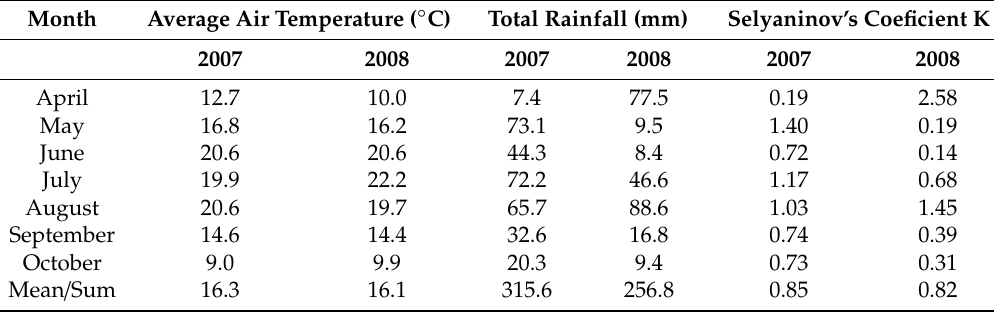
Table 1. Weather conditions during the vegetation period in the years 2007–2008.